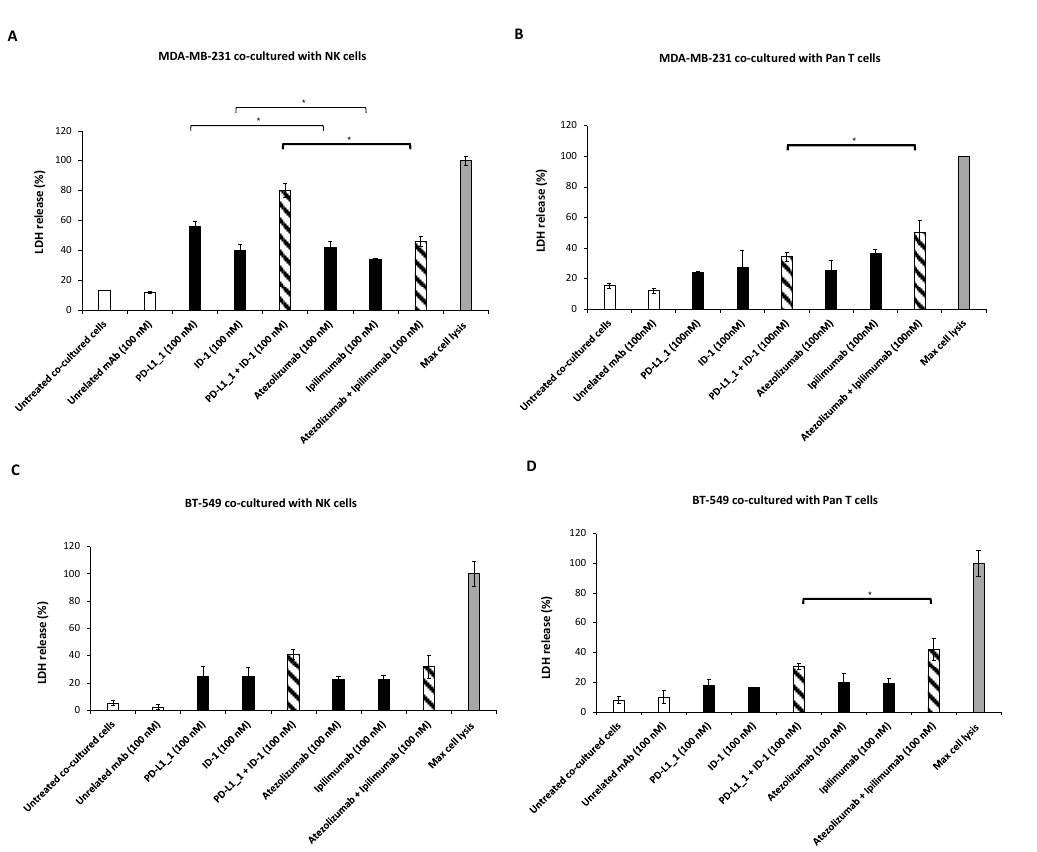
Figure 5. Cytotoxic activity and cytokine secretion induced by the novel immunomodulatory mAbs on MDA-MB-231 and BT-459 TNBC cells co-cultured with NK or Pan T-enriched subpopulations. MDA-MB-231 cells were co-cultured with NK ( A ) or Pan T ( B ); BT-549 cells were co-cultured with NK ( C ) or Pan T ( D ), in the absence or presence of PD-L1_1 or ID-1 mAb, used alone (black bars) or in combination (striped bars), at the indicated concentrations for 48 h. Atezolizumab and ipilimumab were used for comparison in parallel assays. Untreated cells or cells treated with an unrelated mAb were used as negative controls (white and grey bars). The release of LDH was detected in the supernatant of the cells and expressed as previously described. The values were reported as the mean of at least three determinations obtained in three independent experiments. Error bars depict means ± SD. P-values were calculated by comparing each treatment with untreated co-cultured cells or comparing the two combinations with each other and reported as * p < 0.05.